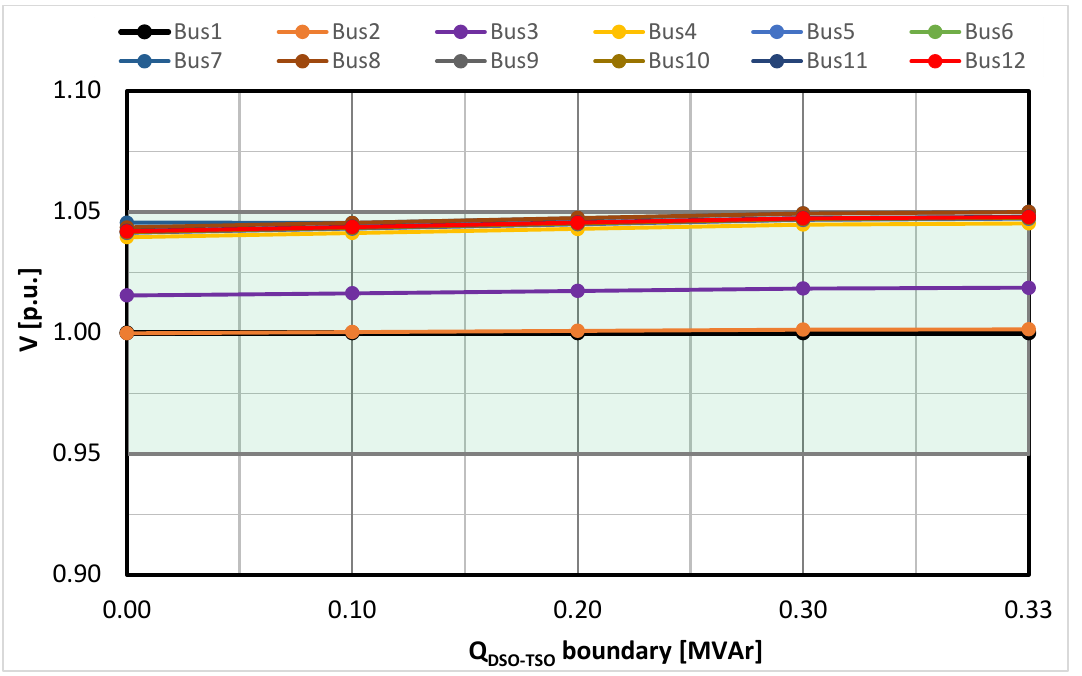
Figure 13. Bus voltages for increasing TSO Q capacitive needs.